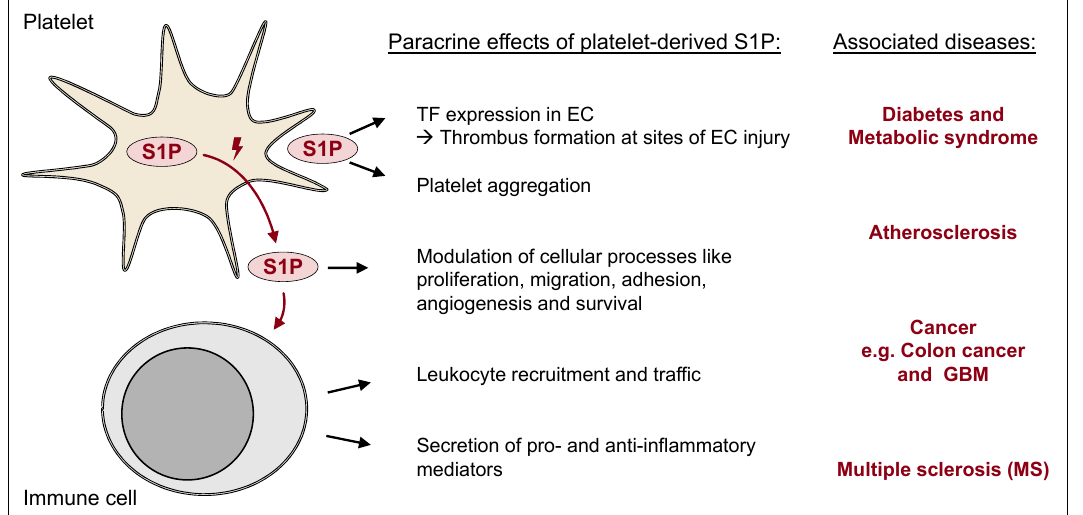
Figure 4. Paracrine effects of S1P on endothelial and immune cells. S1P released from platelets (in bulk during platelet activation 🗲) can affect various cells and cell functions. The focus in this scheme is on the S1P effects on EC or platelets as well as on immune cells, which are attracted by S1P and then release pro- and anti-inflammatory mediators. S1P thus has a direct or indirect influence on various diseases, such as diabetes, atherosclerosis, and MS. EC, endothelial cell; GBM, glioblastoma; MS, multiple sclerosis; S1P, sphingosine-1-phosphate; TF, tissue factor.